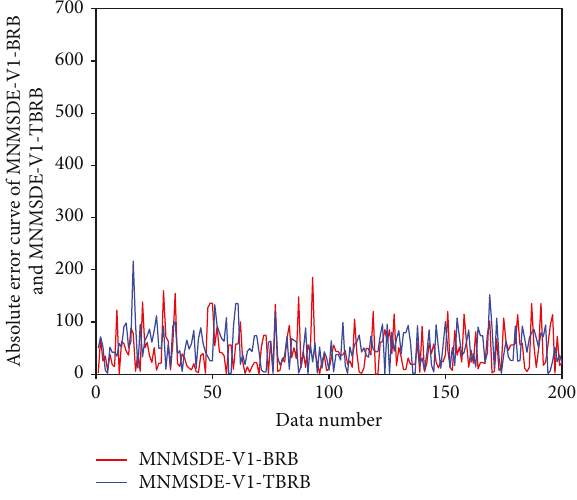
Figure 13: The absolute error of MNMSDE_V1-BRB and